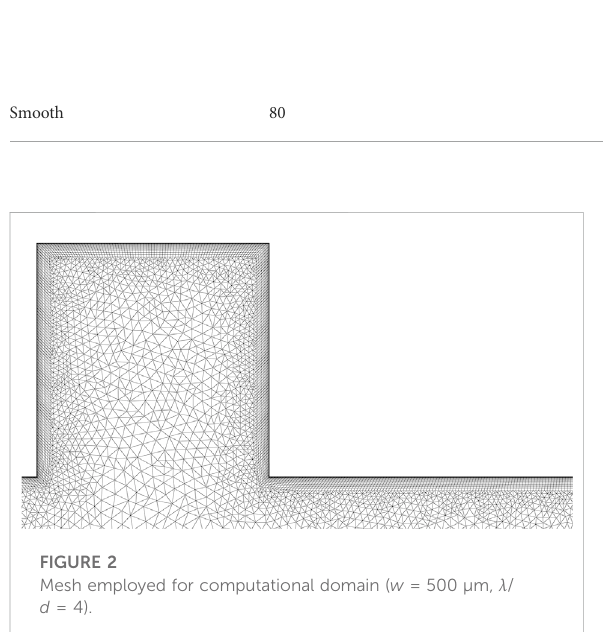
FIGURE 2 Mesh employed for computational domain ( w = 500 μ m, λ / d = 4).